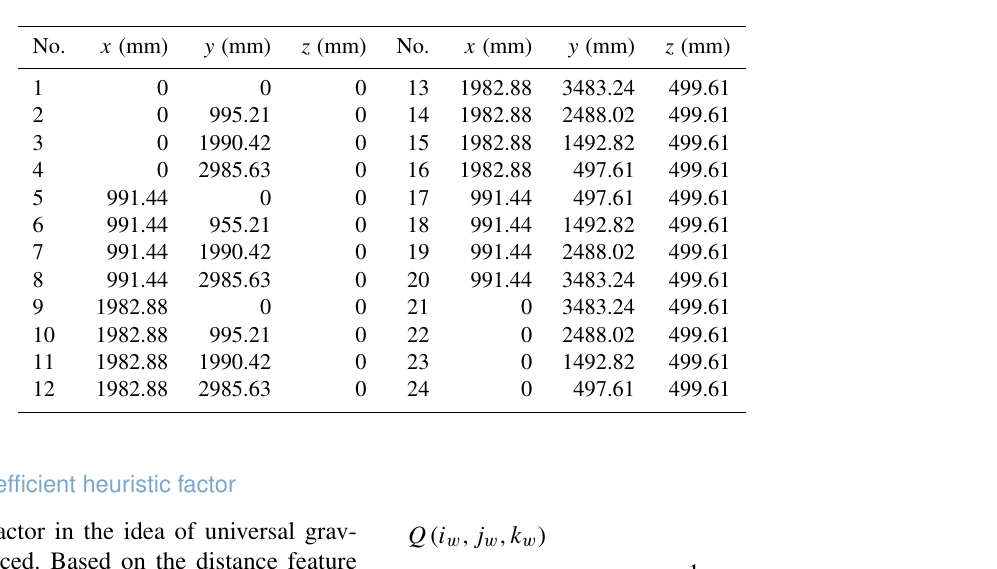
Figure 5. Model of truss in Matlab. Table 1. Truss data model